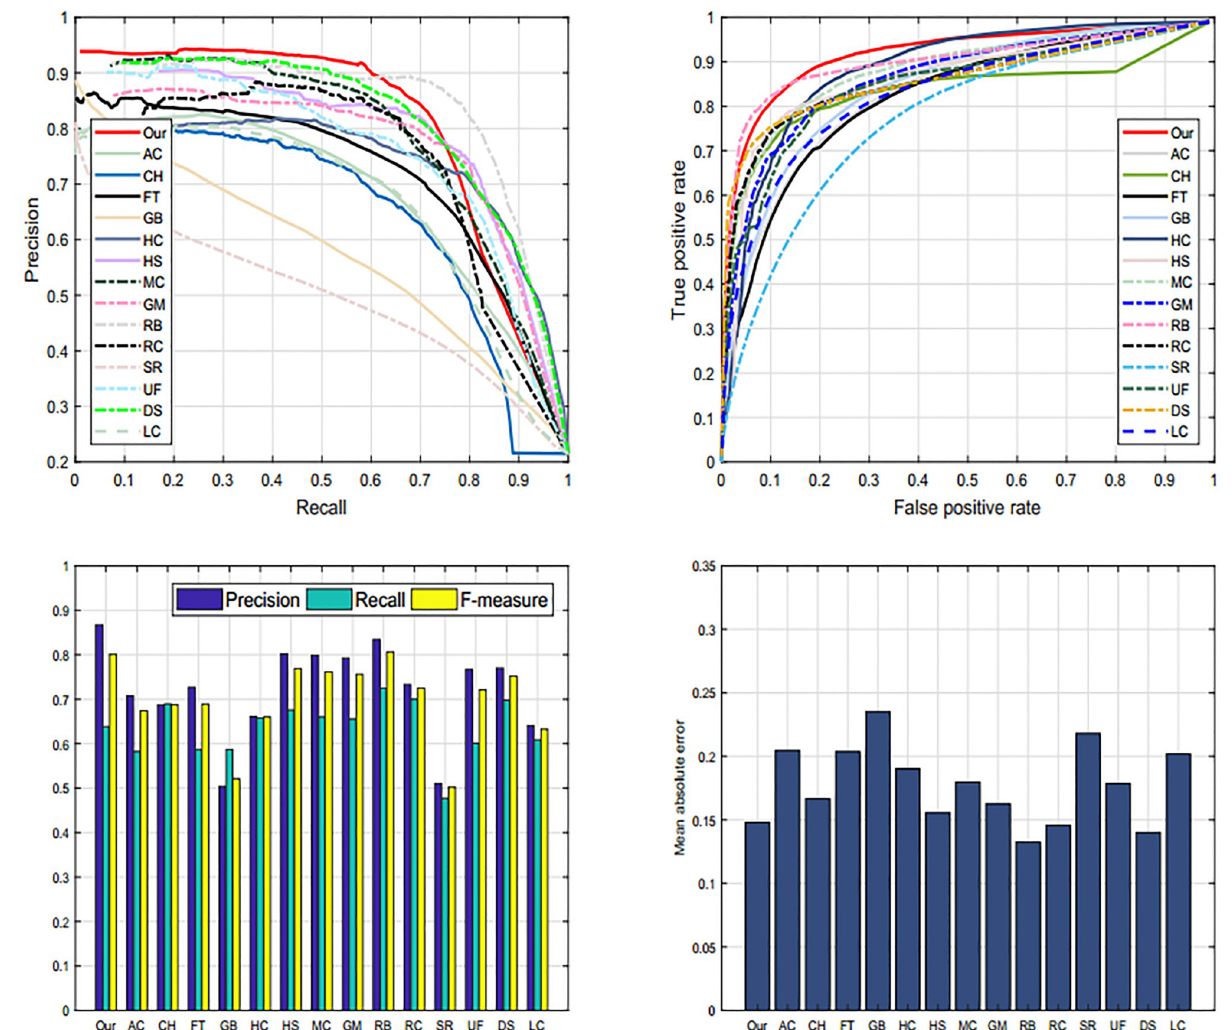
Fig 13. The graphical comparison of proposed model with existing models like: AC [39], CH [44], FT [35], GB [9], HC [10], HS [36], MC [40], GM [5], RB [45], RC [10], SR [43], UF [41], DS [6], and LC [42] on the SED2